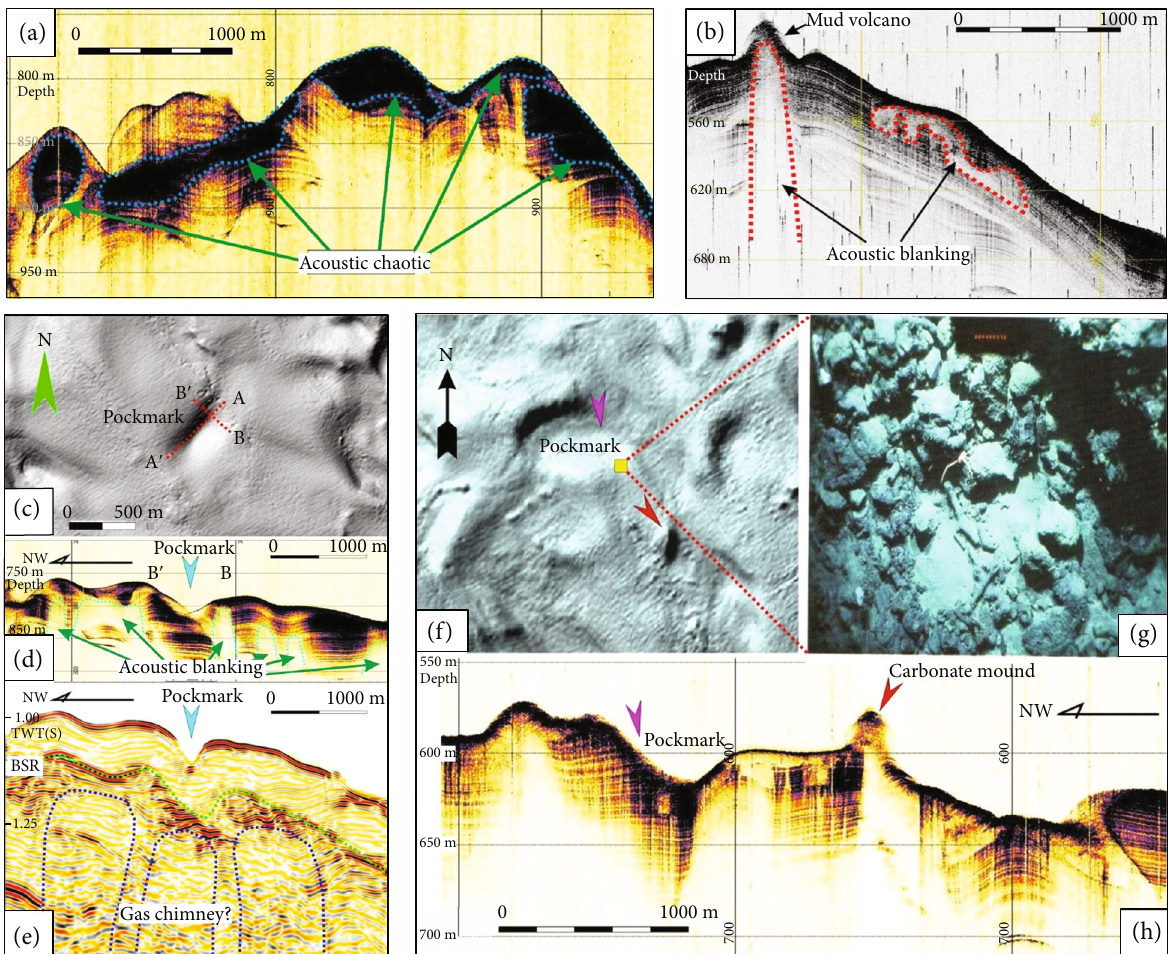
Figure 6: Subbottom pro fi le and seismic pro fi le showing the microgeomorphological features associated with the cold seep and gas hydrate accumulation in the Dongsha area (modi fi ed from Shang et al. [105] and Shang et al. [106]). The pockmarks are closely related to the gas- bearing fl uid migration from the deep strata, which are indicated by the acoustic blanking and the chaotic features on the subbottom and seismic pro fi les. The submarine mound with authigenic carbonate pavement resulted from gas hydrate dissociation and the seepage of